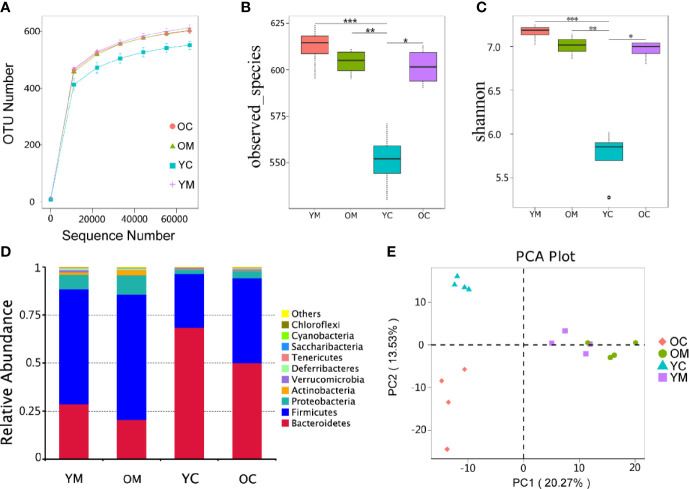
Effect of aging on microbiota composition, n=4 mice per group. (A) Rarefaction curves for OTU number in four groups. The curve in each group all reaches plateau; (B, C) α diversity (as accessed by observed species and shannon index) based on the general profile in the four groups (***p=0.0004, YM vs YC; *p = 0.0116, OC vs YC; for observed species; ***p=0.0001, YM vs YC; *p = 0.0115, OC vs YC; for Shannon; p values are calculated from Wilcoxon rank sum test); (D) Composition of fecal microbiota at the phylum level of four group; (E) PCA plot of microbiota communities cluster in feces of four group.